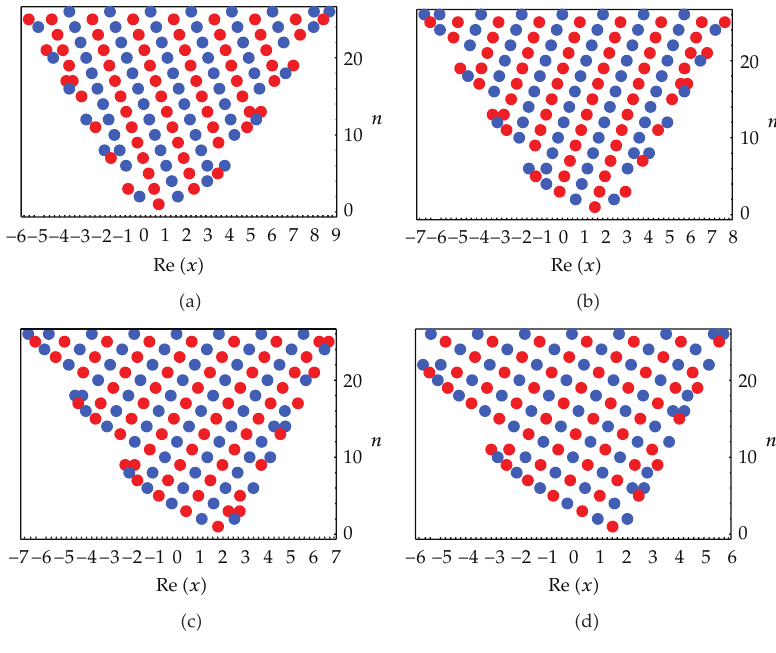
Figure 3: Real zeros of E n,q,w (cid:2) x : a (cid:3) for 1 ≤ n ≤ 25.